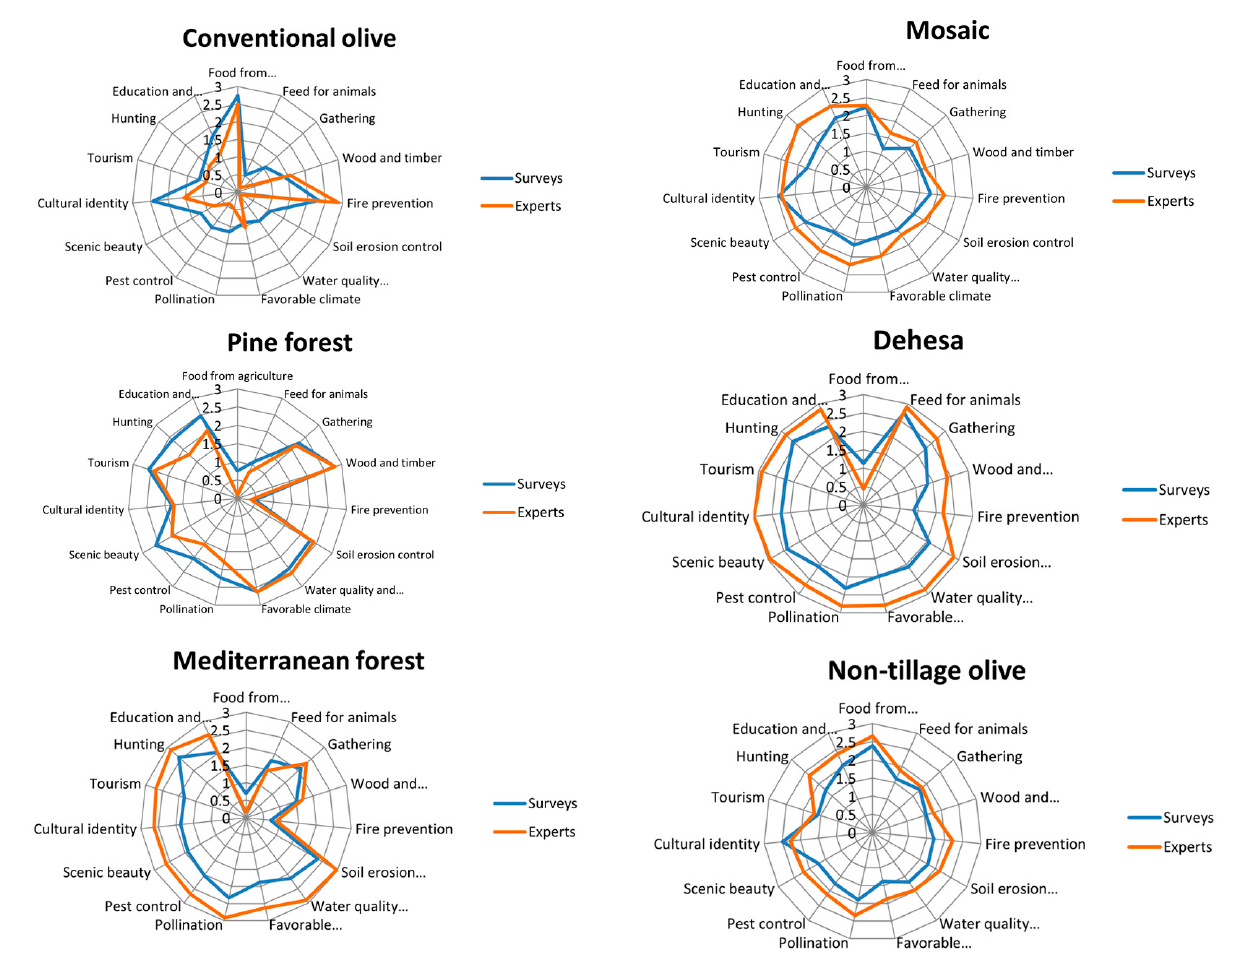
Figure 5. Radar graphs of ecosystem services delivery perceptions for each